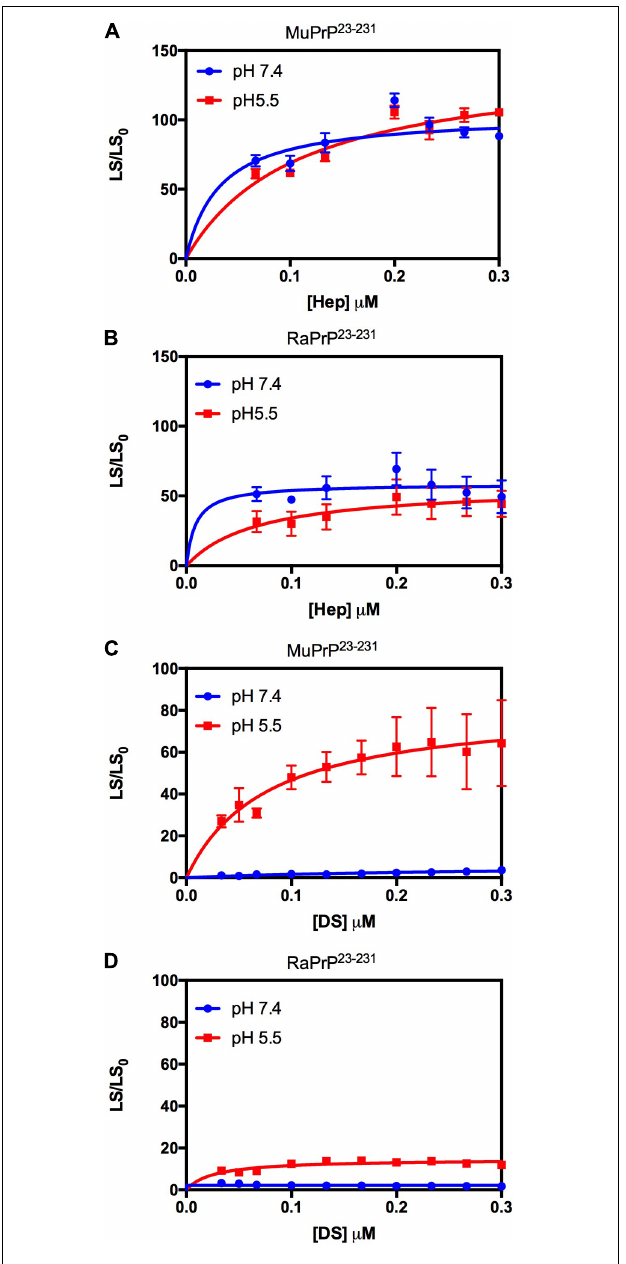
FIGURE 2 | Rabbit PrP 23 − 231 aggregates less in the presence of GAGs. Effect of increasing concentrations of Hep (A,B) and DS (C,D) on the aggregation of MuPrP 23 − 231 (2 µ M) (A,C) and RaPrP 23 − 231 (2 µ M) (B,D) at pH 5.5 (red) and 7.4 (blue). Representative data from three experiments. The experiments were performed in 50 mM Tris buffer containing 100 mM NaCl at pH 7.4 or in 20 mM sodium acetate buffer containing 100 mM NaCl at pH 5.5. All experiments were performed at 25 ◦ C. The error bars represent